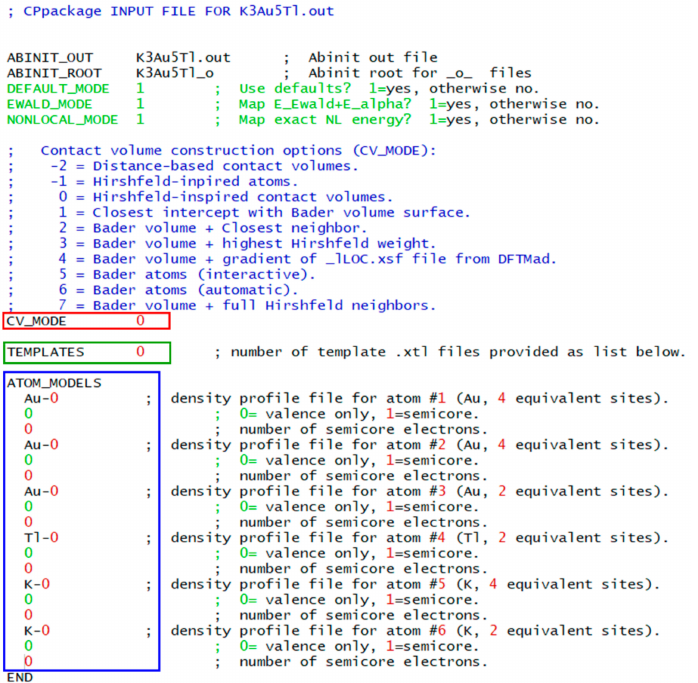
Figure 3. CPpackage generated .ini file for the expanded volume geometry of K 3 Au 5 Tl. The red, green, and blue boxes highlight areas that are commonly adjusted during CP